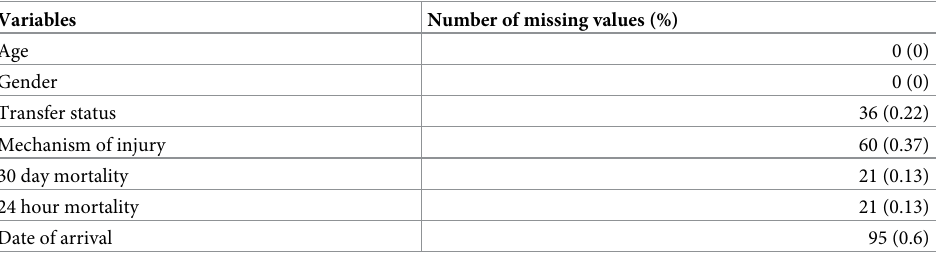
Table 1. Missing data per